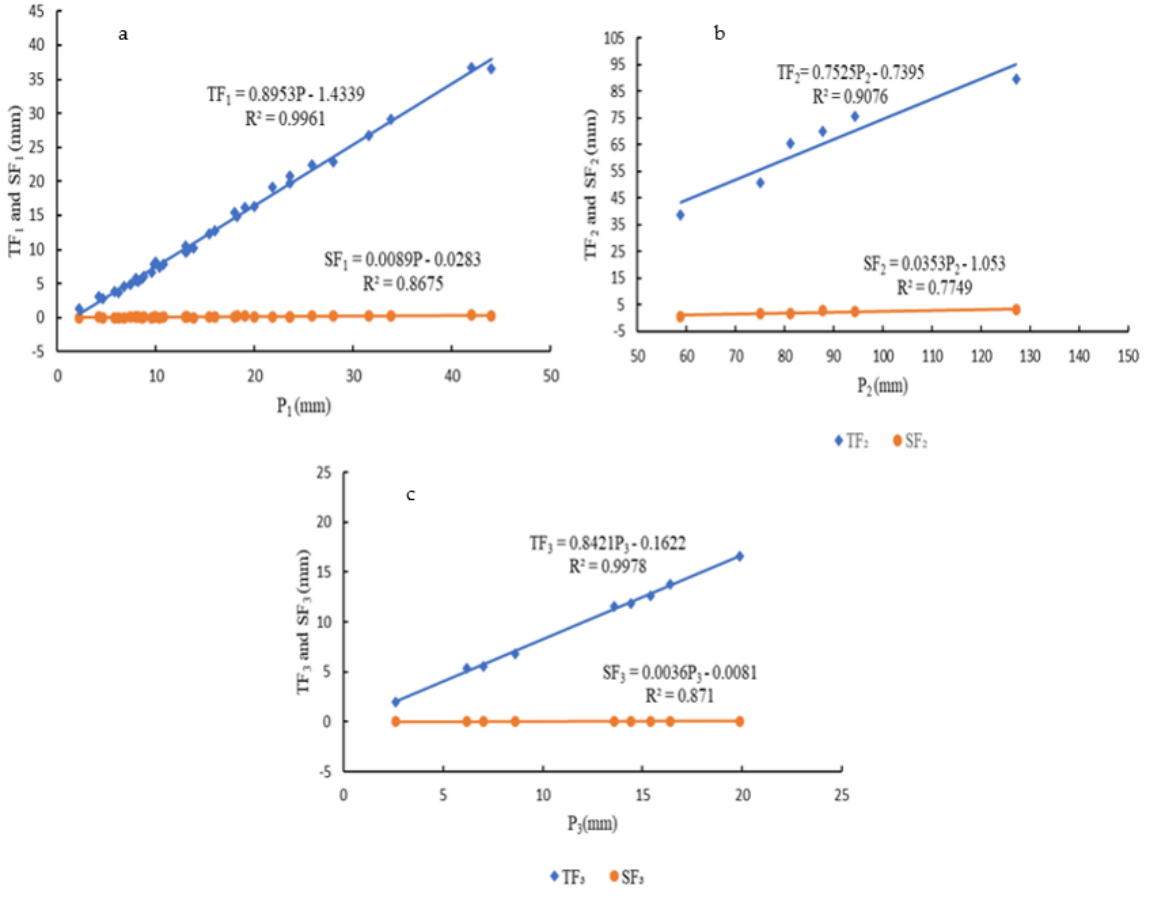
Figure 4. Relationships between stemflow (SF), throughfall (TF), and rainfall amount (P) in the studied plot. ( a ): Rainfall pattern A; ( b ): rainfall pattern B; ( c ): rainfall pattern